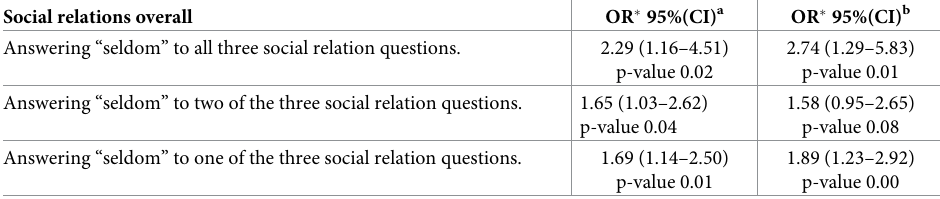
Table 4. The association between overall social relations and mental ill-health. Social relations overall OR � 95%(CI) a Answering “seldom” to all three social relation